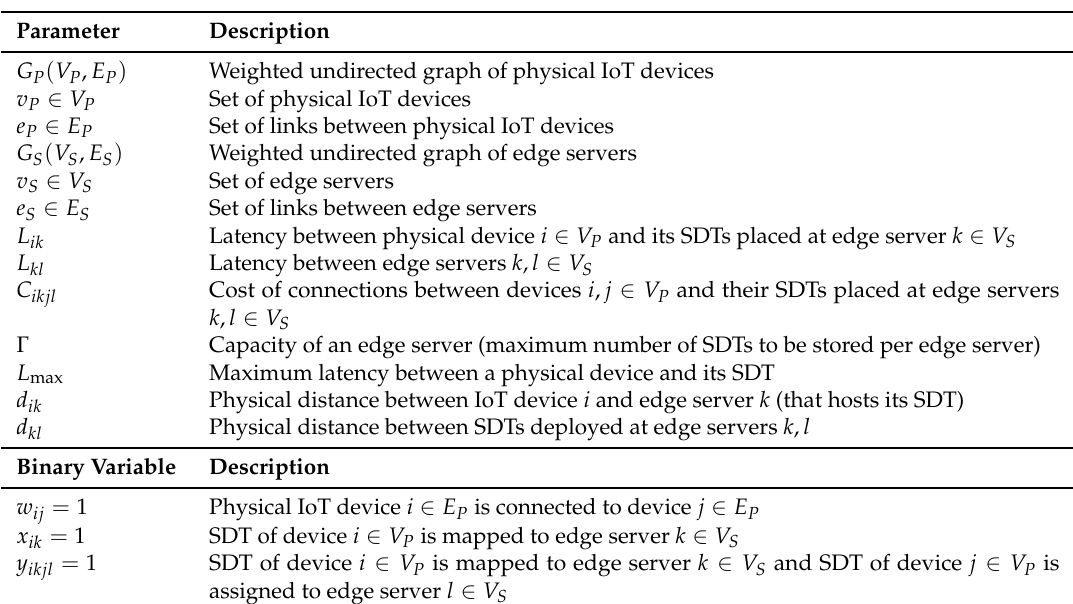
Table 1. Description of notations.